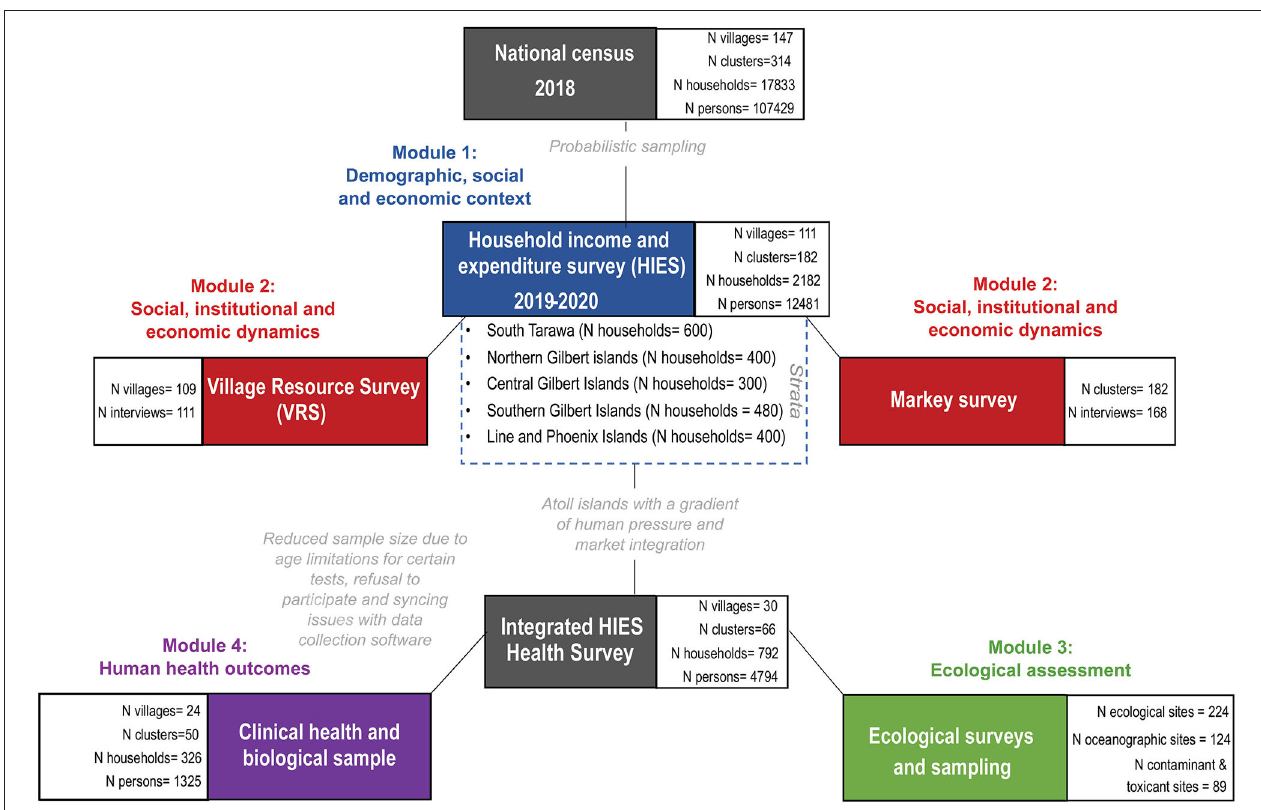
FIGURE 2 | Consort figure detailing integrated study